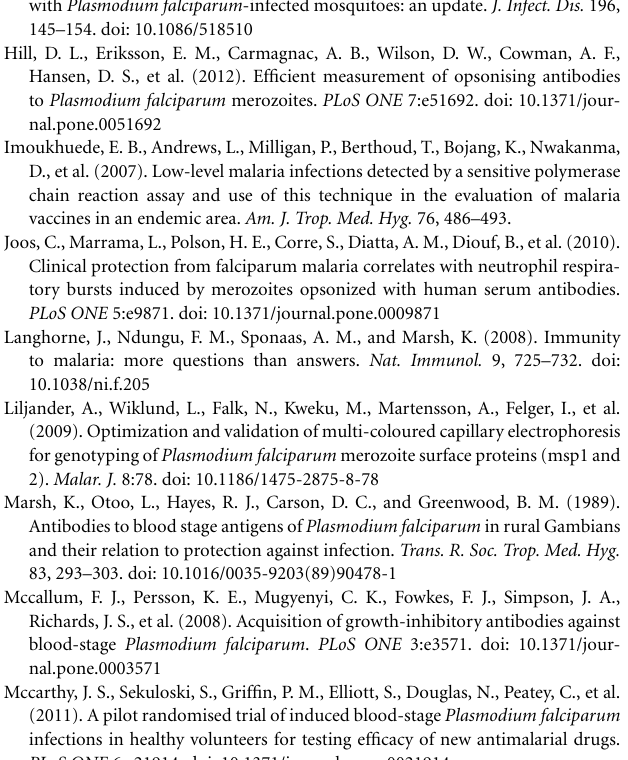
Figure S3 | qPCR-measured parasite density over time for each individual subject. Y-axis = Parasites/mL measured by qPCR. X-axis = days post-injection of PfSPZ Challenge. Black subtitles indicate participant identification